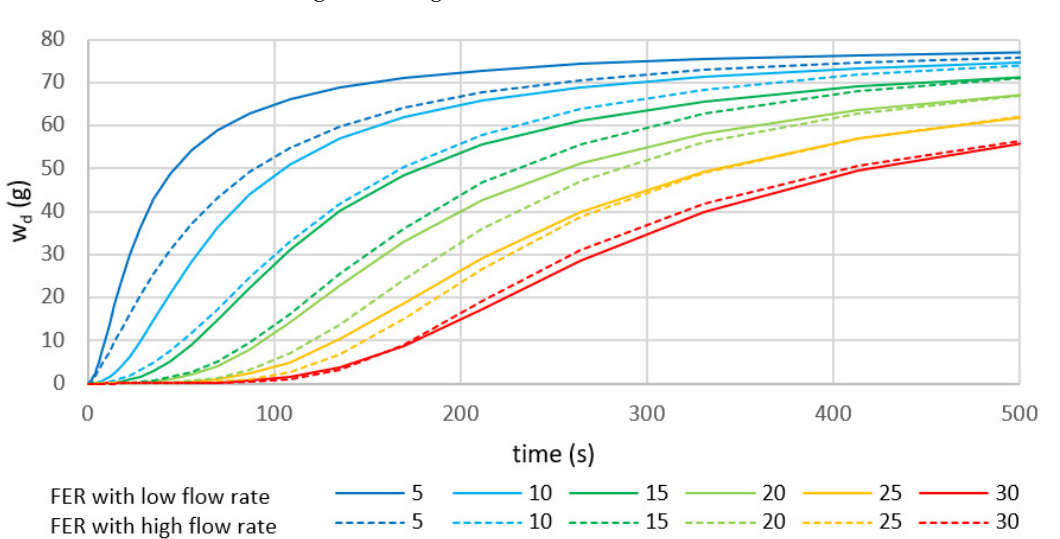
Figure 10. Drained weight vs. time for different FER and for high flow rate generation (solid lines) and low flow rate generation (dashed lines).